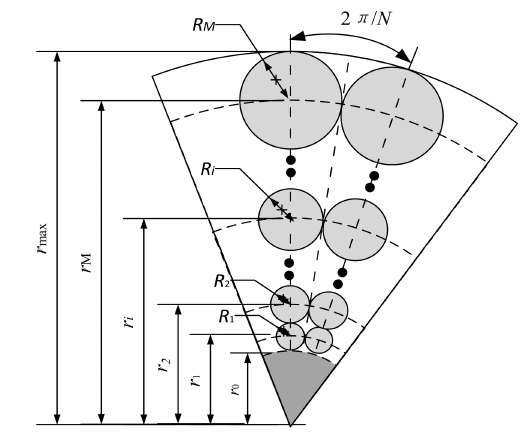
Figure 2. The sample model of retina-like imaging.